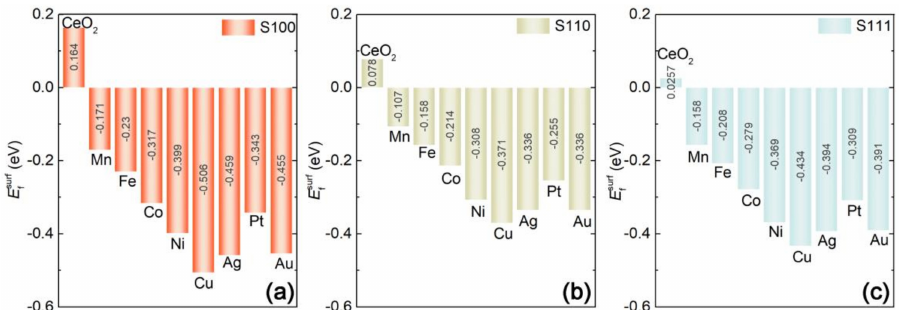
Figure 2. Surfaces formation energy ( E surf S100, ( b ) for S110 and ( c ) for